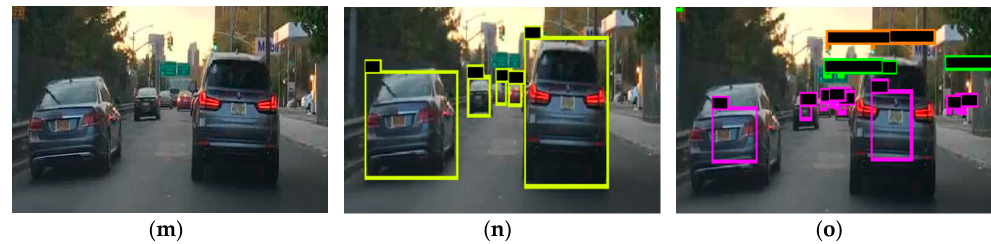
Figure 5. The figure ( a – o ) show the results of multiple pictures detected by models trained on two di ff erent datasets. Images in figure ( a , d , g , j , m ) are raw pictures. Images in figure ( b , e , h , k , n ) are detected by the model trained on COCO dataset. Images in figure ( c , f , i , l , o ) are detected by the model trained on BDD100K dataset. The same pictures used two models trained by two datasets to detect the object. The yellow boxes indicate the model with YOLO that was trained on the COCO dataset to detect vehicles. The purple boxes indicate the model with YOLO that was trained on the BDD100K dataset